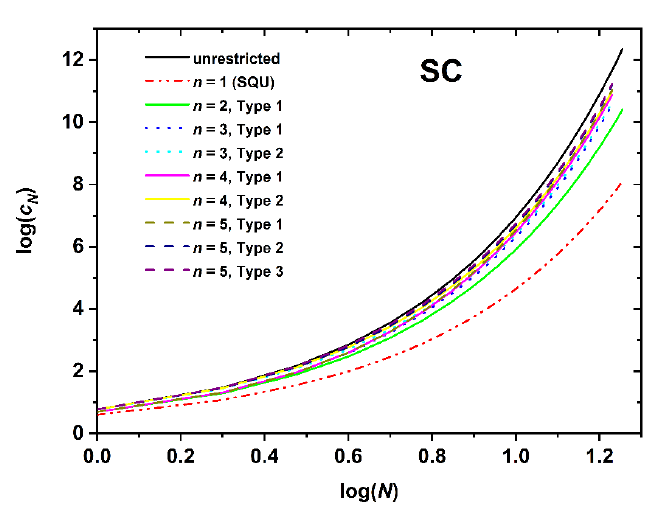
Figure 5. Logarithm of the number of distinct SAWs, c N , versus the logarithm of the number of SAW steps, N , as obtained from direct enumeration on the SC lattice under plate-like confinement. n corresponds to the number of layers between the confining plates. Label “Type” corresponds to different SAW origin as explained in Figure 1 and related text. The most extremely confined case of n = 1 corresponds to the 2-D square lattice (SQU).